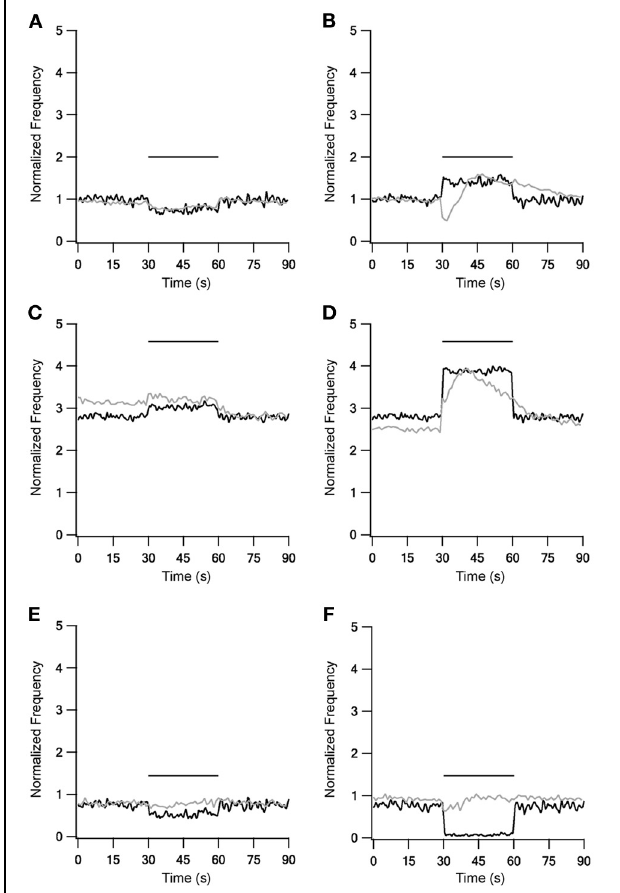
FIGURE 2 | Model and experiment results during low (LFS) and high frequency stimulation (HFS). Response frequency over time normalized to mean prestimulus frequency under control conditions. Left column shows LFS results under control conditions (A) , during blockade of inhibition (C) and blockade of excitation (E) . Right column shows HFS results under control conditions (B) , during blockade of inhibition (D) and blockade of excitation (F) . Black traces, model results; gray traces, normalized population average recorded from GP neurons in vitro (Bugaysen et al., 2011). Horizontal bars indicate the stimulation period. In these experiments inhibition was blocked with 50 μ M bicuculline and excitation with 15 μ M CNQX and 50 μ M